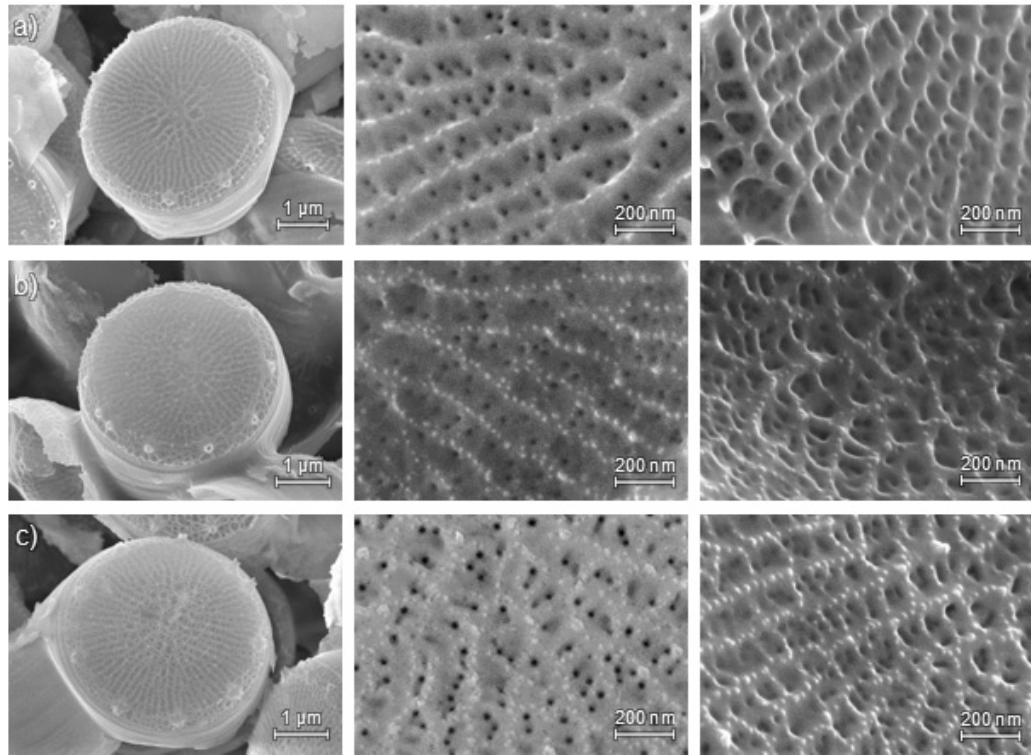
Figure 1. SEM images of calcined T.p. frustules; left: whole valve, center: detailed frontal view, right: detailed view with tilted valve face; ( a ) reference sample, ( b ) cultured under elevated aluminum levels; ( c ) cultured under elevated aluminum levels, after ion exchange.